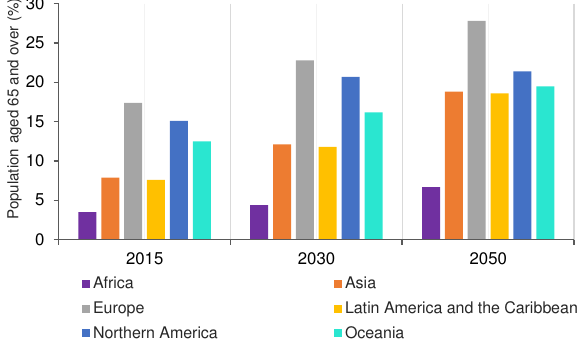
Figure 1. Population aged 65 and over by region. Adapted from: